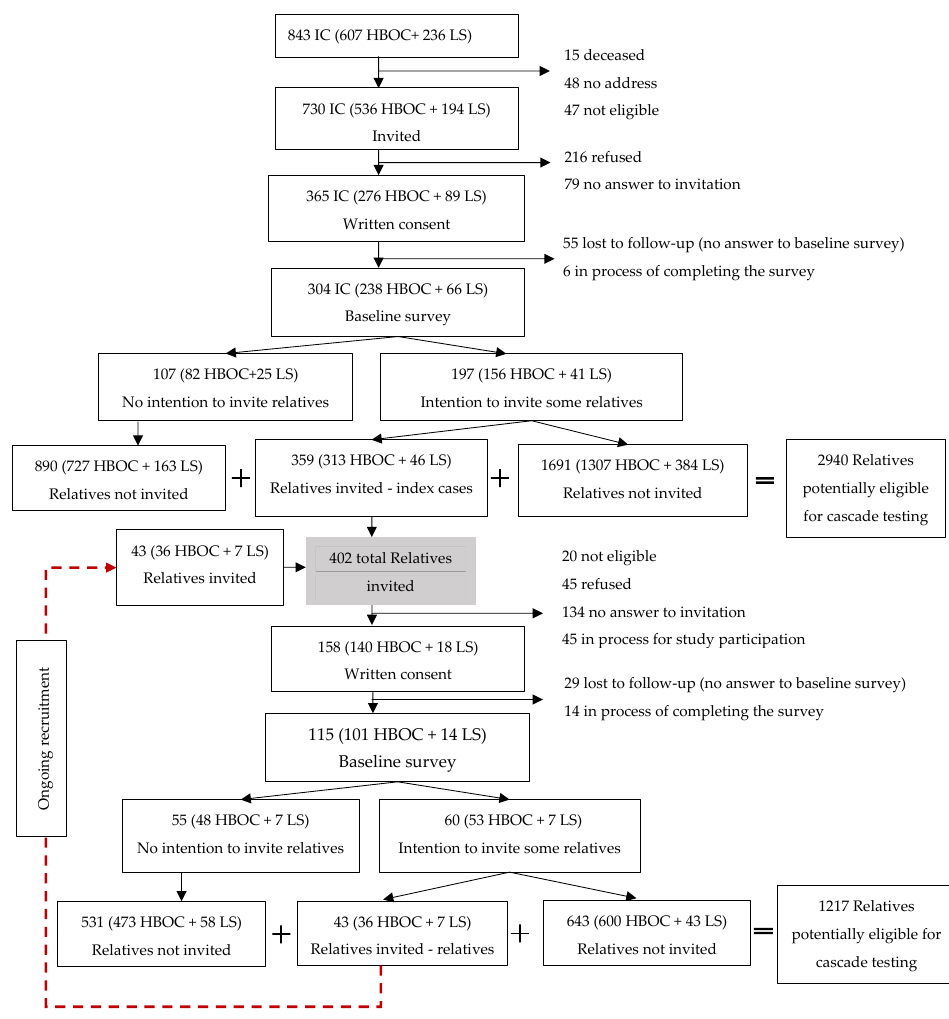
Figure 1. Consort diagram of recruitment process in the CASCADE cohort.